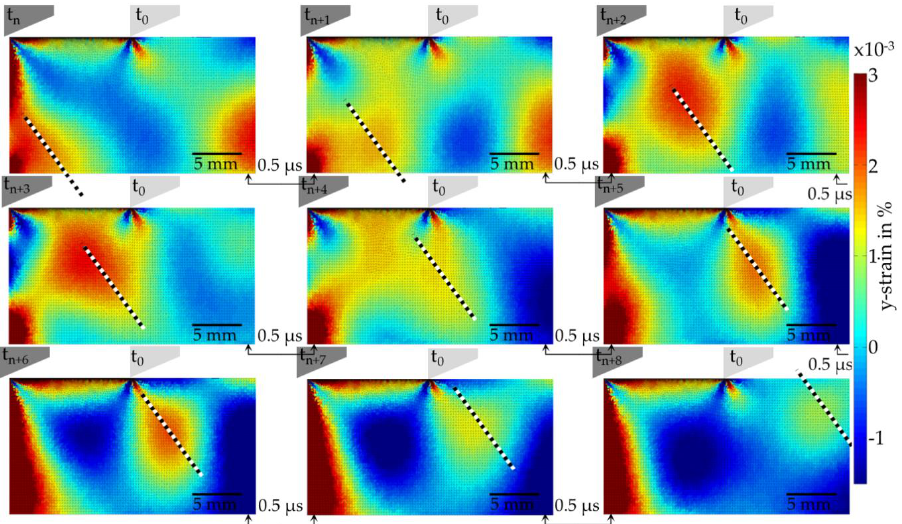
Figure 12. FEM simulation of shock waves after chip breakage for different time steps. The black and white dotted line is located on the maximum of the strain releasing from the lower left and symbolizes the strain front propagating through the material.